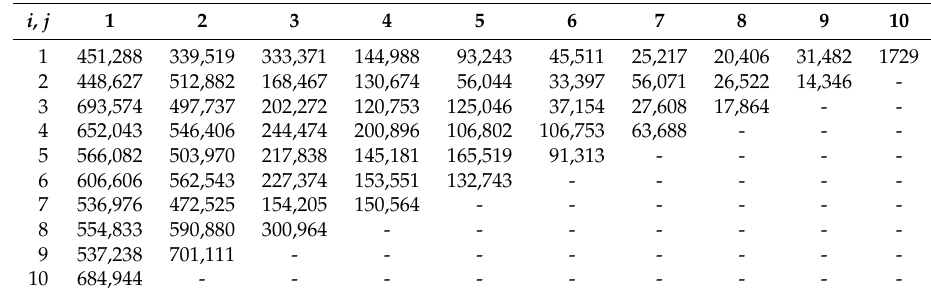
Table 1. Run-off triangle taken from Verrall et al. (2010) with an indication for splitting into sub-samples corresponding to the first and last five accident years. Accident years i in the rows; development years j in the